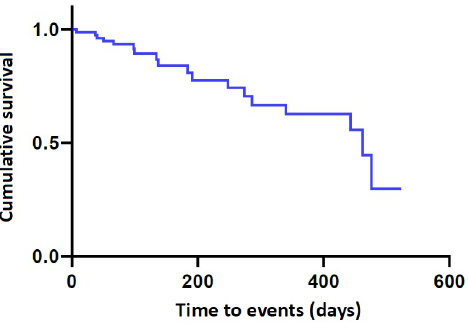
Figure 5. Kaplan–Meier cumulative survival. In our series, the time-to-events were estimated at 386.68 ± 27.79 days (95% CI 334.11–439.27).